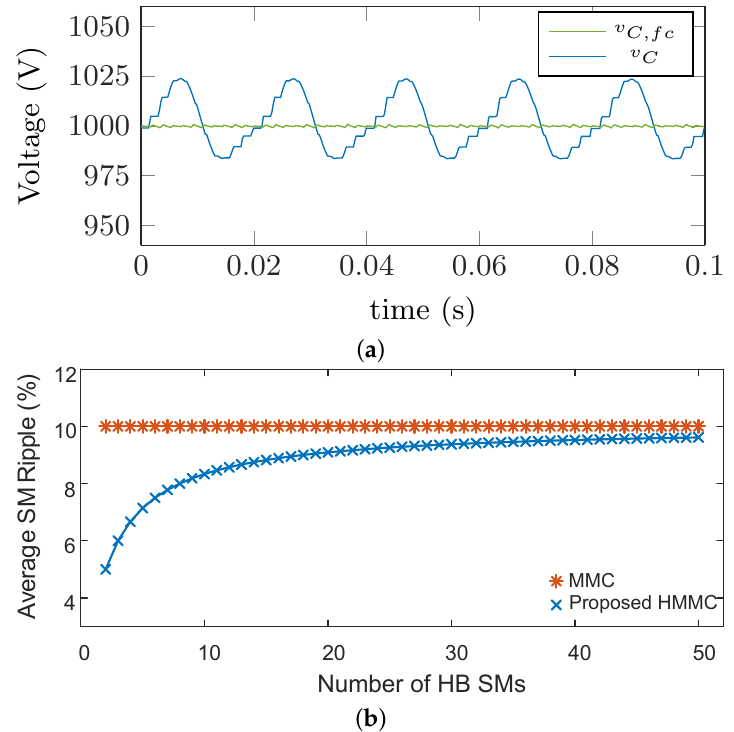
Figure 9. ( a ) Comparison of FC-SM capacitor voltage and ( b ) HB-SM capacitor voltage in the HMMC. Figure 9. Comparison of FC-SM Capacitor voltage and HB-SM capacitor voltage in the HMMC.